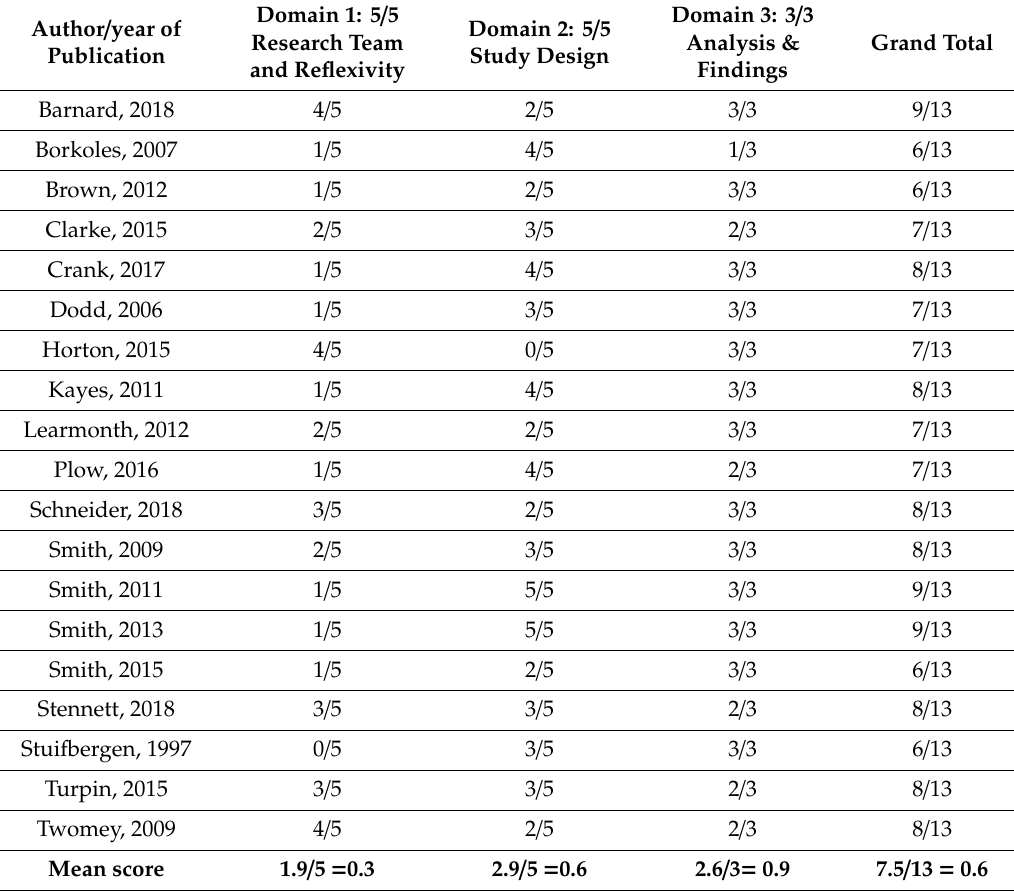
Table 2. The summary scores of the 13 items COREQ appraisal